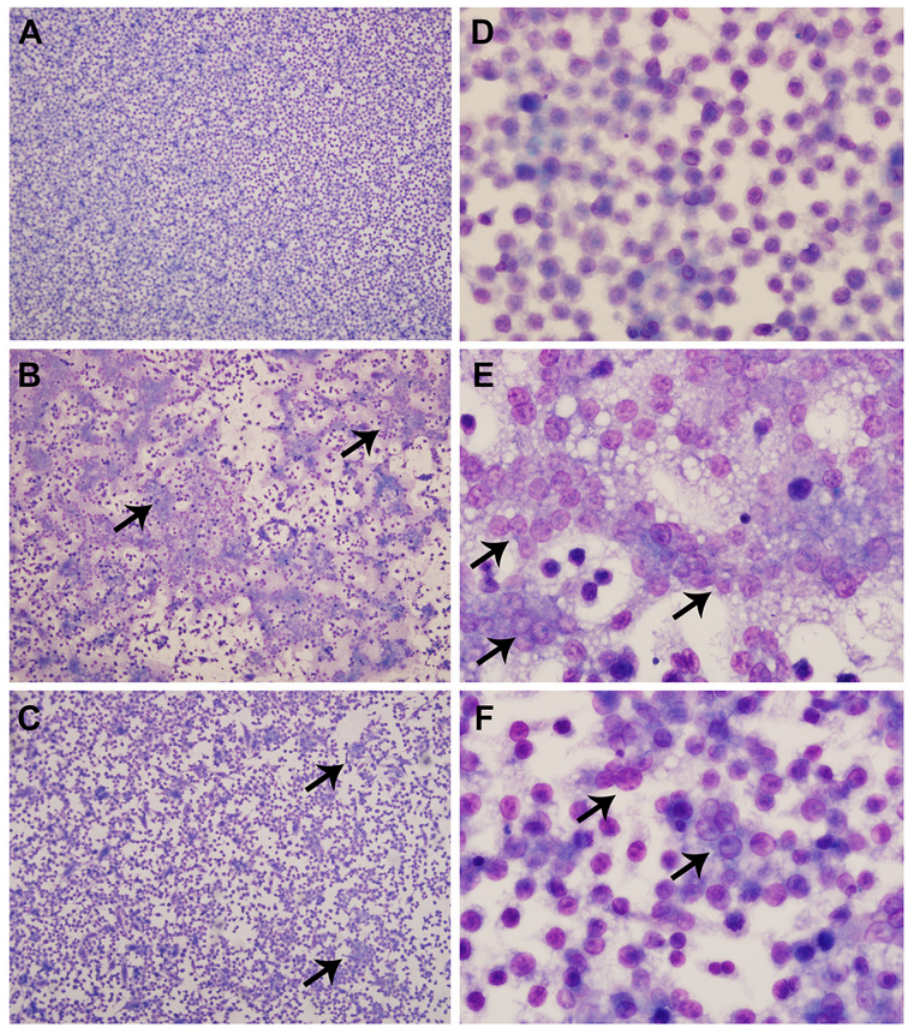
Fig 6. Comparative phenotypes of macrophages infected with strain 1106a or HBPUB10134a. Morphological changes in cells and in the extent of cell death/detachment as observed in Diff-Quik stains of cultures at the 8 h time point. The typical normal appearance of uninfected semi-confluent J774.A1 cells at low power, 100x (A) and high power, 600x (D) . B, E: Cells infected with 1106a, showing loss of monolayer and presence of numerous MNGCs and clusters of fused necrotic cells at 100x (B) and 600x (E) . C, F: Cells infected with HBPUB10134a and viewed at 100x (C) and 600x (F) demonstrated cell loss to a lesser extent than those with 1106a and promoted MNGC formation, albeit fewer in number and smaller in size. The arrows indicate examples of